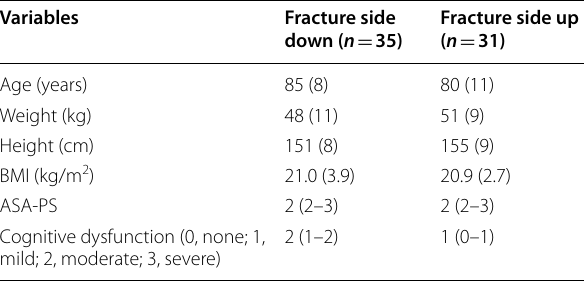
Data are presented as mean (SD) or median (IQR) ASA-PS American Society of Anesthesiologists Physical Status, BMI Body mass index, SD Standard deviation, IQR Interquartile range